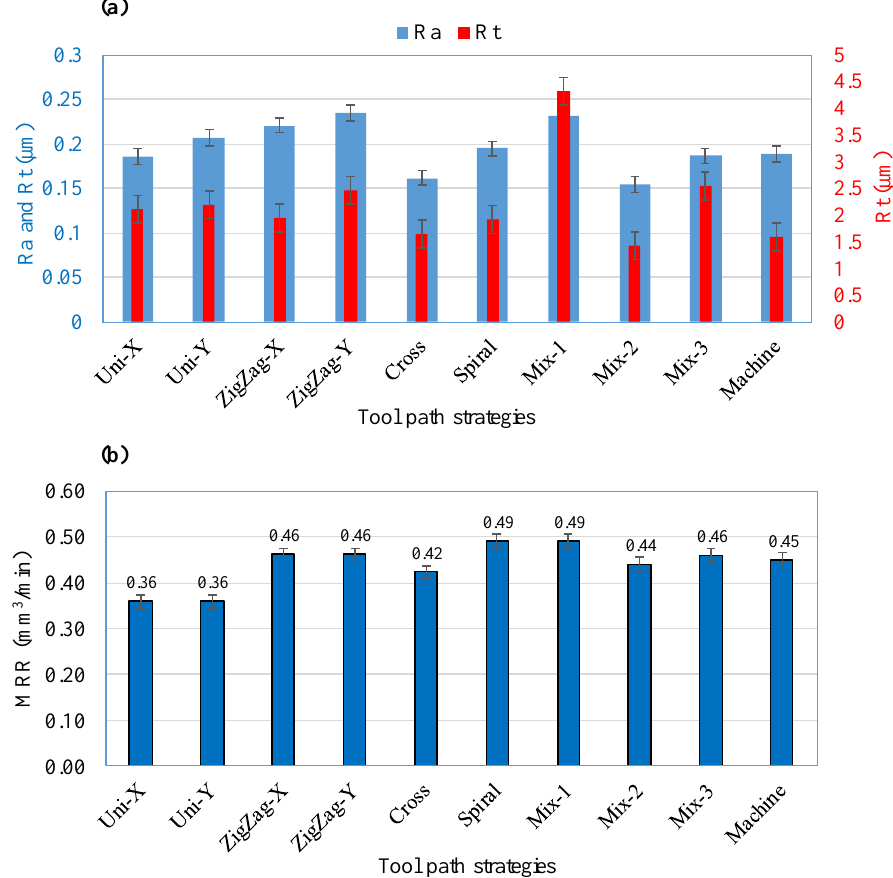
Figure 10. ( a ) E ff ects of tool path strategies on Ra and Rt and ( b ) e ff ects of tool path strategies on Figure 10. ( a ) Effects of tool path strategies on Ra and Rt and ( b ) effects of tool path strategies on MRR.